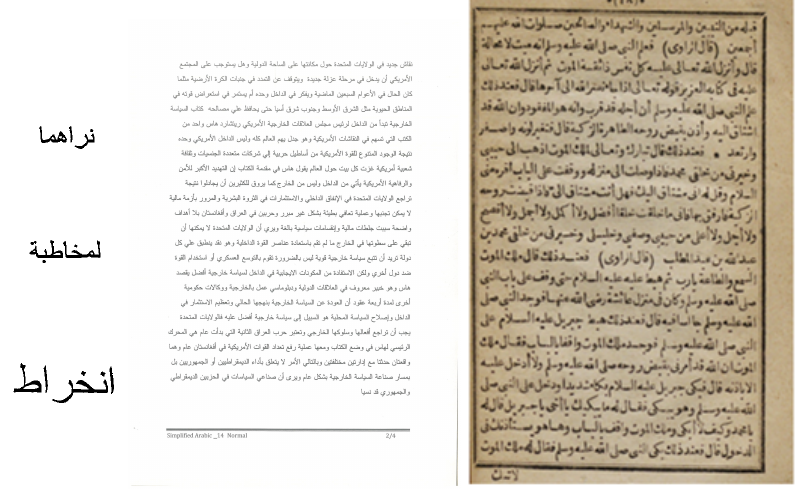
Figure 6. Some samples of the scanned